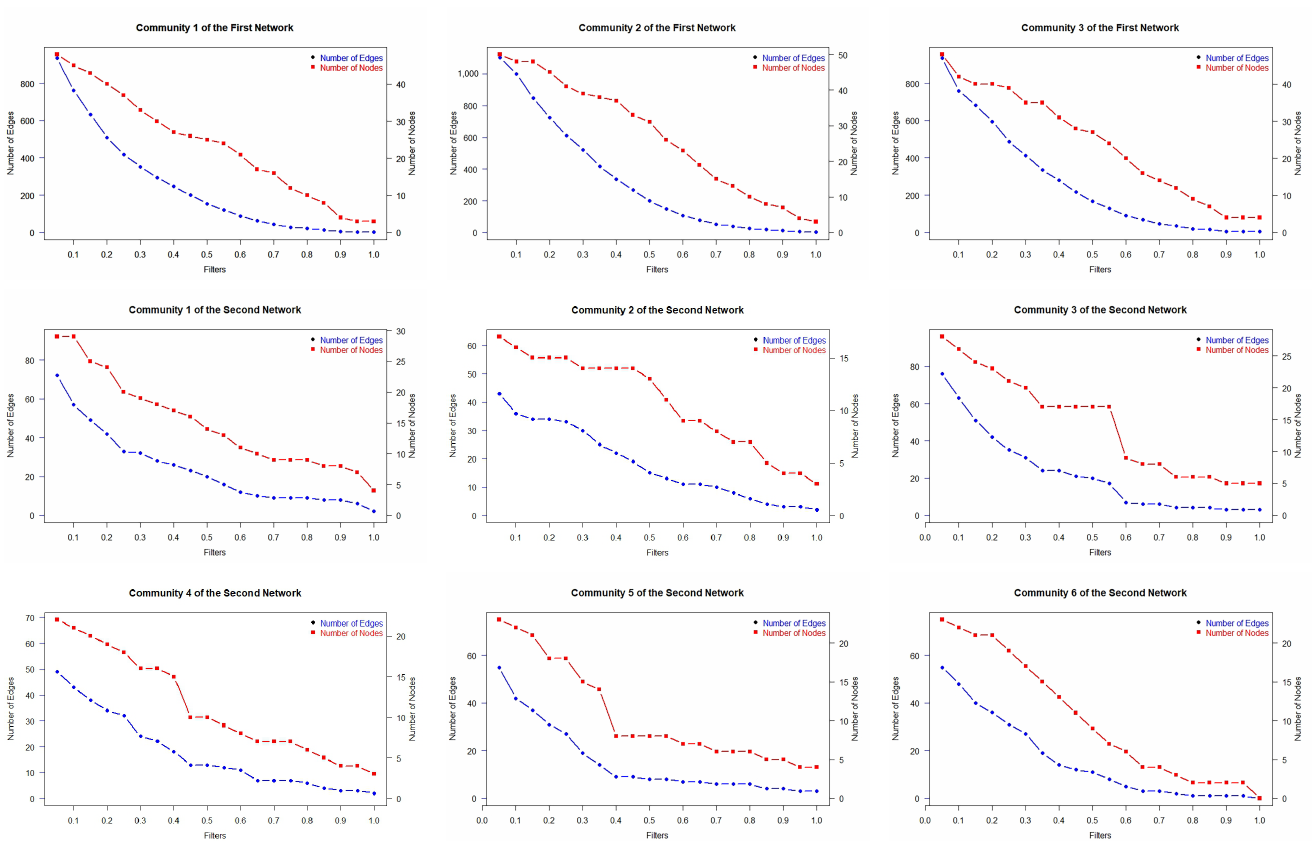
Figure 12. Effect of filtering on the number of nodes and edges for each community in the first and second